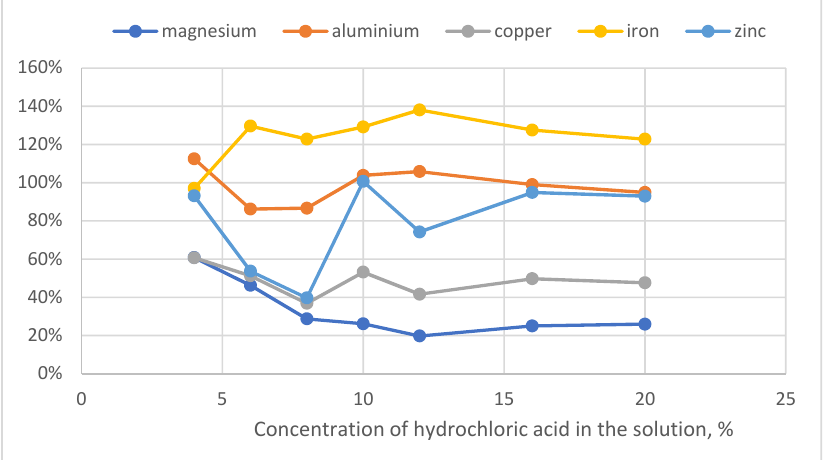
Figure 9. Effectiveness of extraction increase (%) for various minerals and concentrations of hydro- chloric acid.